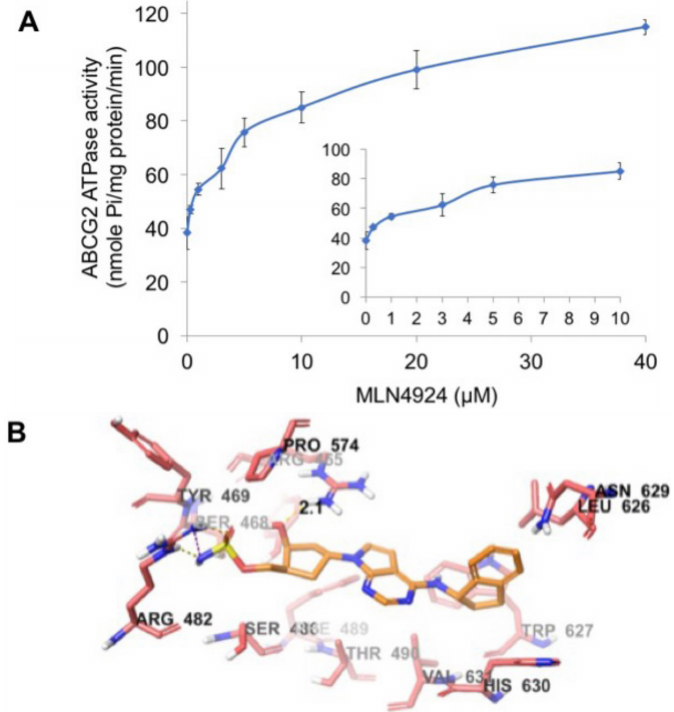
Figure 6. MLN4924 stimulates ABCG2 ATPase activity. ( A ) E ff ects of various concentrations of MLN4924 on the ATPase activity of ABCG2. The inset graph illustrates the e ff ects of 0–10 µ M